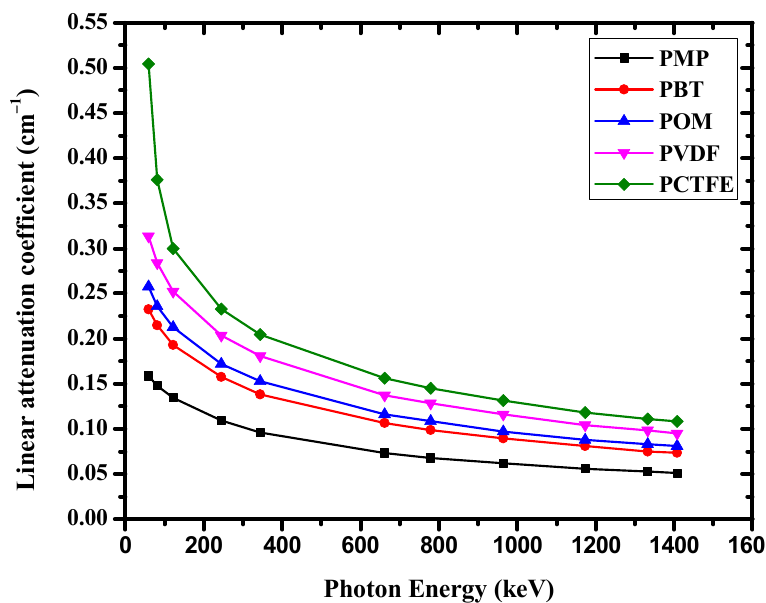
Figure 4. Geant4 linear attenuation coefficients of the present polymers as a function of photon energy.